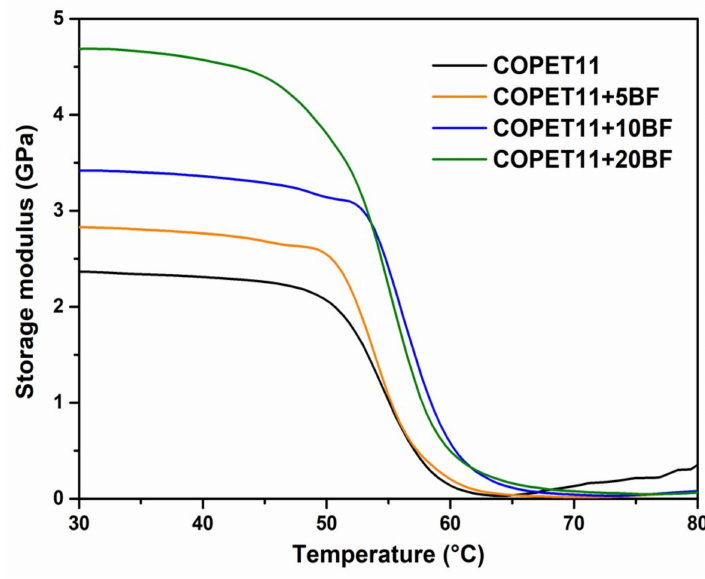
Figure 11. Storage moduli of COPET11 and composites.